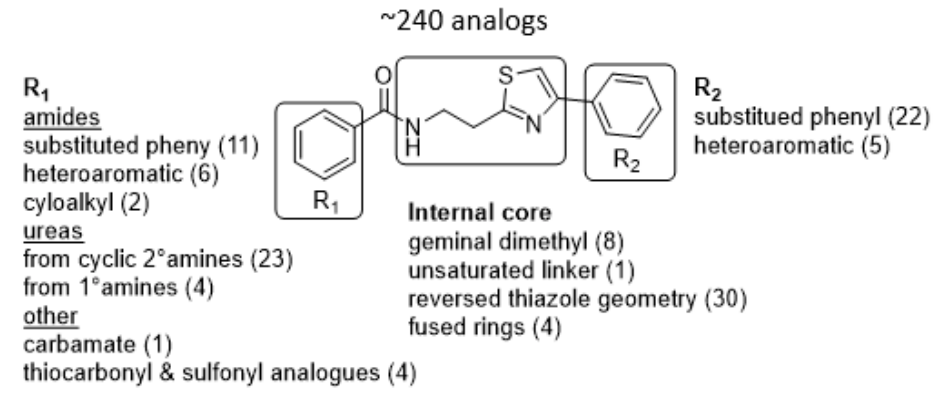
Figure 1. Medicinal chemistry strategy for optimization of Scaffold 2.